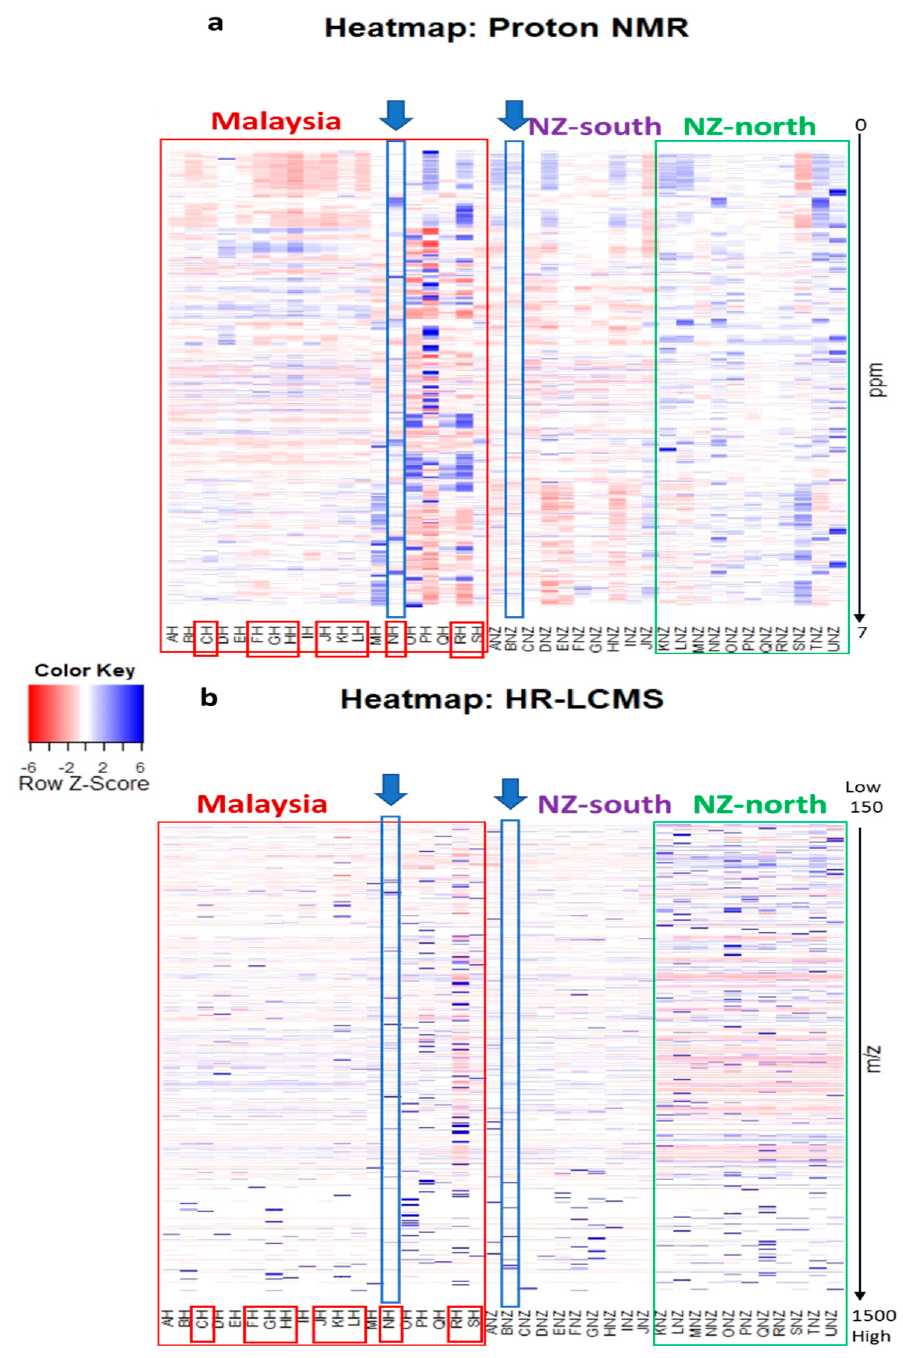
Figure 1. Heatmaps based on ( a ) 1 H-NMR and ( b ) HR-LCMS data displaying distinct chemical pro- files of 42 extracts, where the components highlighted in red box represent the samples from Ma- laysia. The components outside the red box are from New Zealand. Legend: NZ-south = South Is- land New Zealand honey, NZ-north = North Island New Zealand honey. Bioactive extracts were boxed in red. Enclosed in blue boxes under an arrow are samples NH and BNZ that have the greatest number of features identified by HR-LCMS. Bar intensities from red to blue, respectively, indicate the decrease and increase in concentration of individual metabolites in corresponding samples.